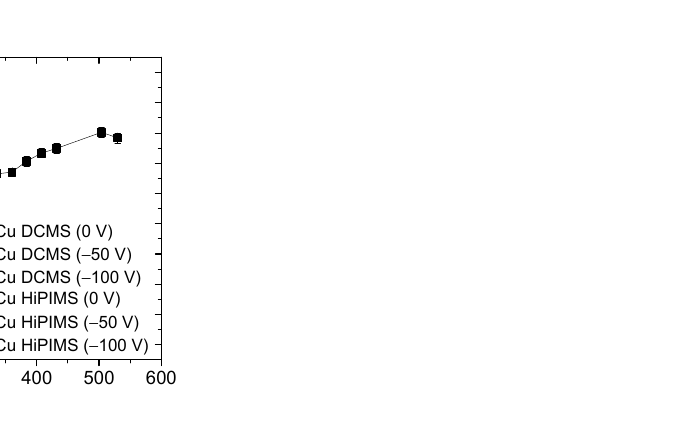
Figure 7. Quantitative evaluation of absorption spectra as a function of time evolution for all copper films.